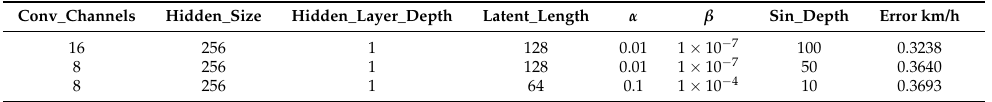
Table A2. Summary of the best hyper-parameters of the Autoencoder: CONV-LSTM-SineNet.